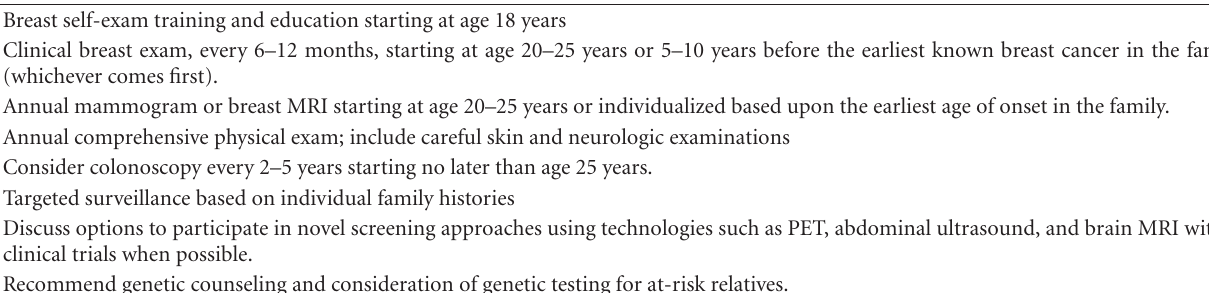
Table 3: NCCN Li-Fraumeni screening guidelines. Breast self-exam training and education starting at age 18